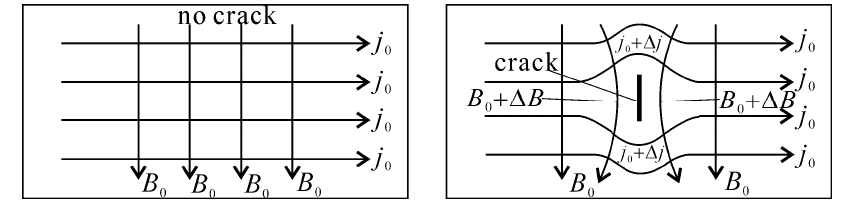
Figure 6. Schematic diagram of current perturbation.